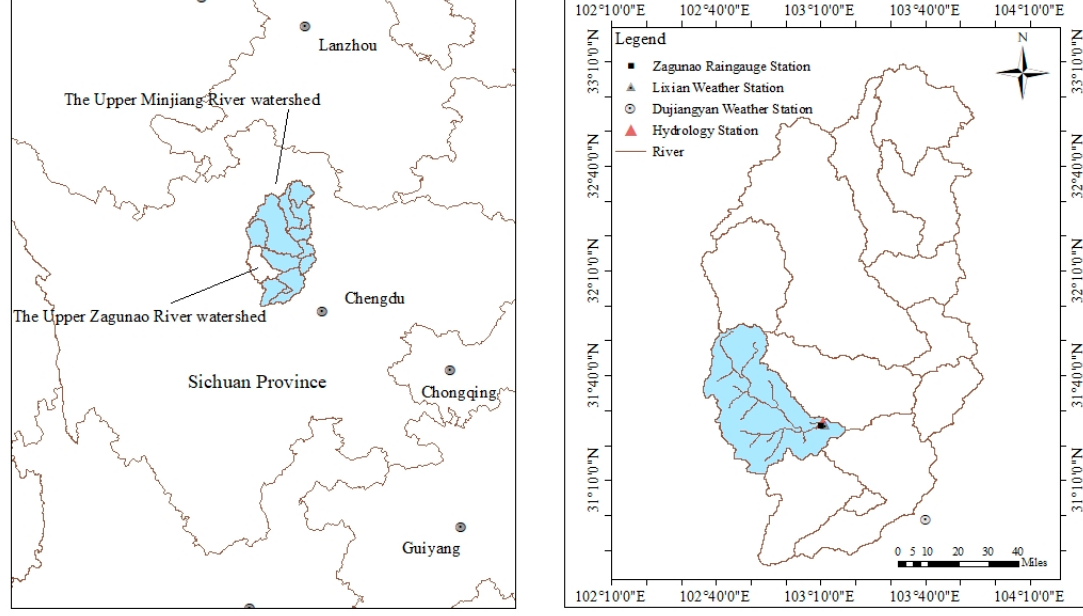
Figure 1. Location of the Upper Zagunao River Watershed.